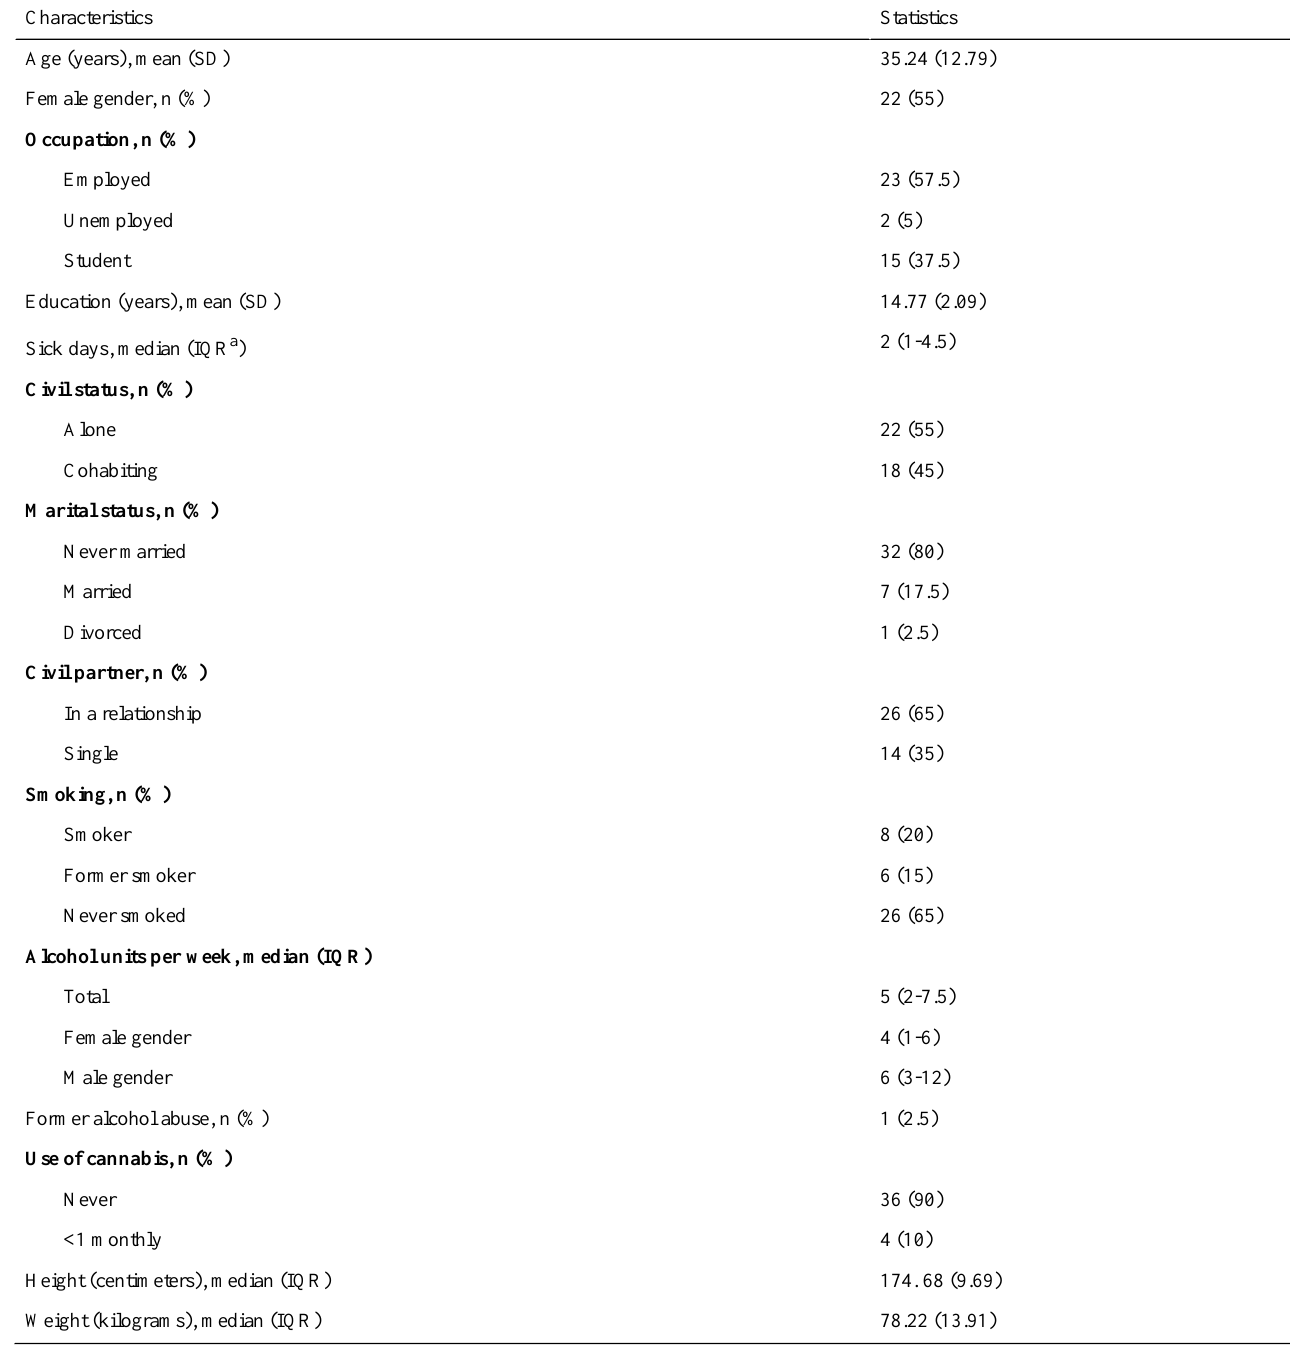
Table 1. Background and sociodemographic characteristics of study participants (N=40).